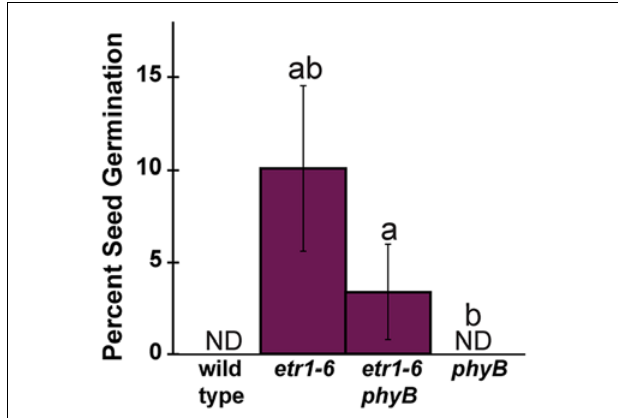
FIGURE 9 | Epistasis analysis of ETR1 and PHYB in the dark. Seeds were germinated in the dark for 7 days and the percent of seed germination was then determined.The average ± SD from at least three biological replicates is plotted. ND denotes no germination detected.The data were analyzed by t -tests and differences considered statistically significant with P < 0.05. a Statistical difference from wild-type in that light condition; b Significant difference of the single mutant from the double